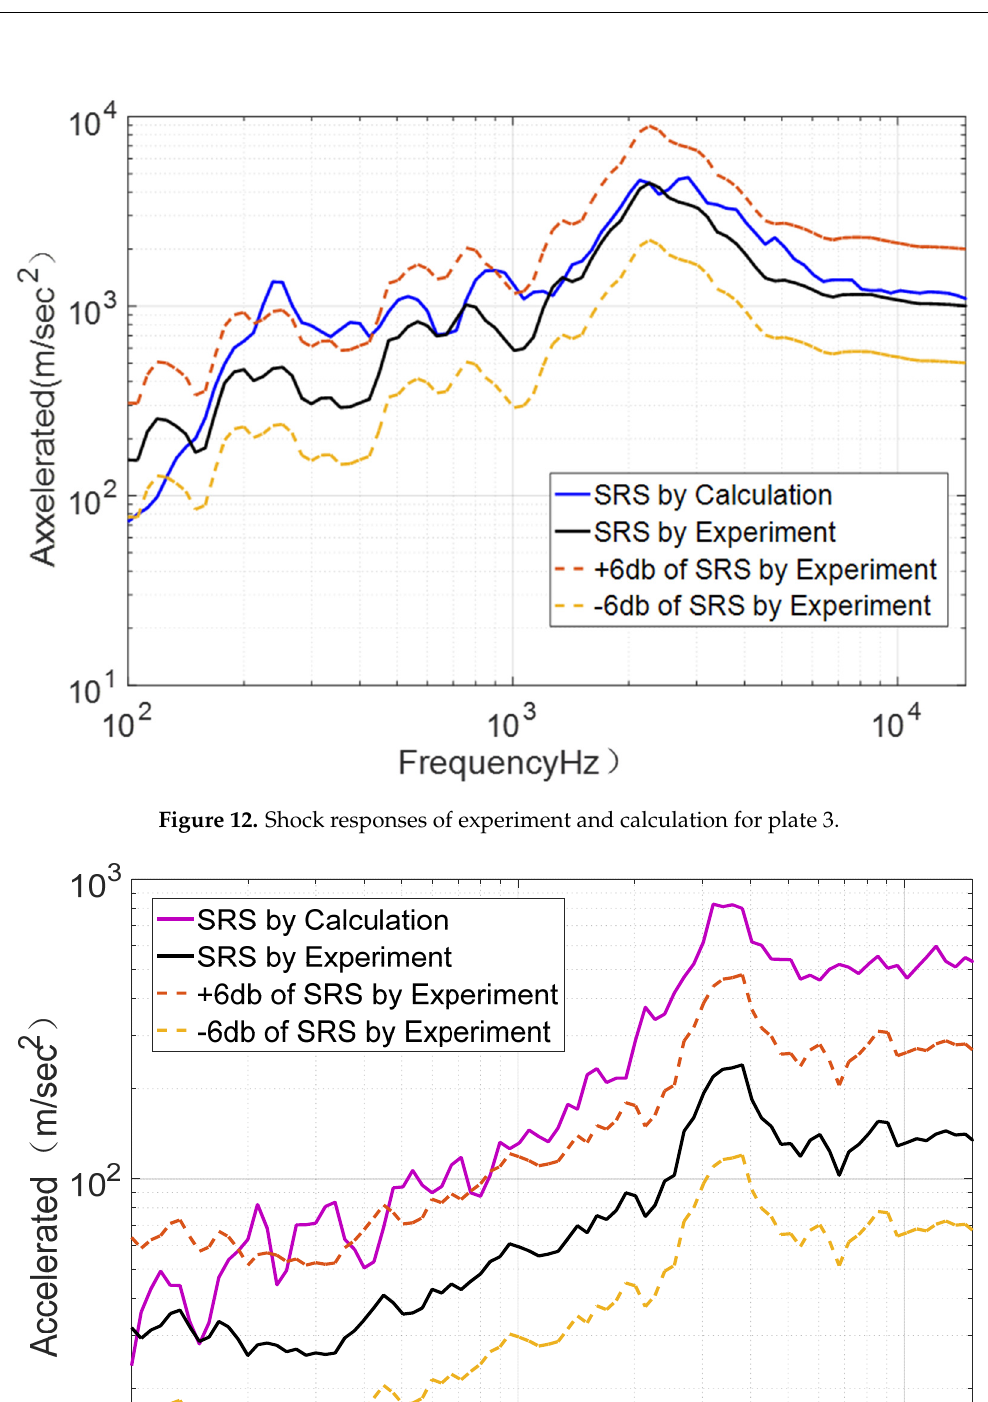
Figure 11. Shock responses of experiment and calculation for plate 2.